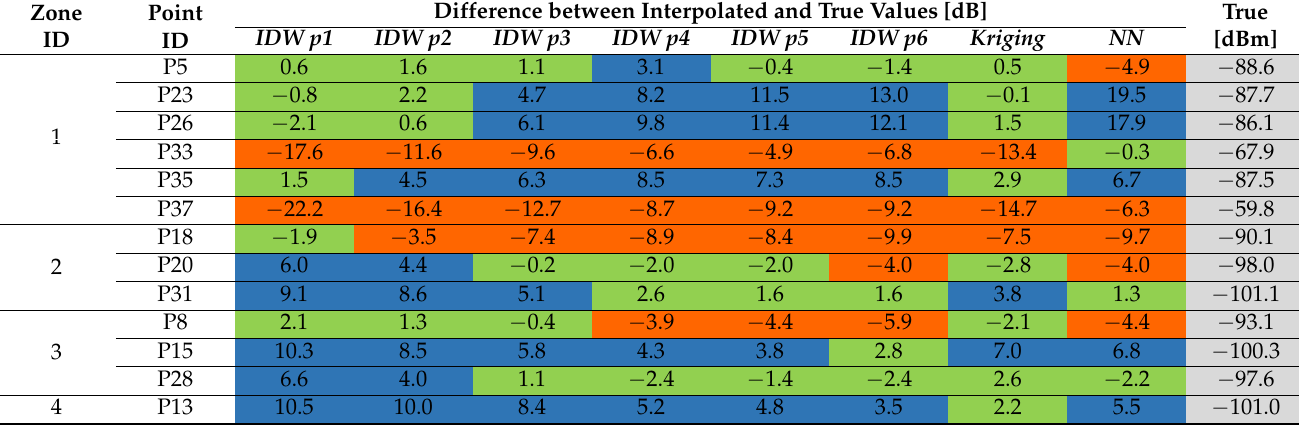
Table 5. Difference between interpolated and true value for 13 control points and various interpolation methods (Test_26a). Zone Point ID